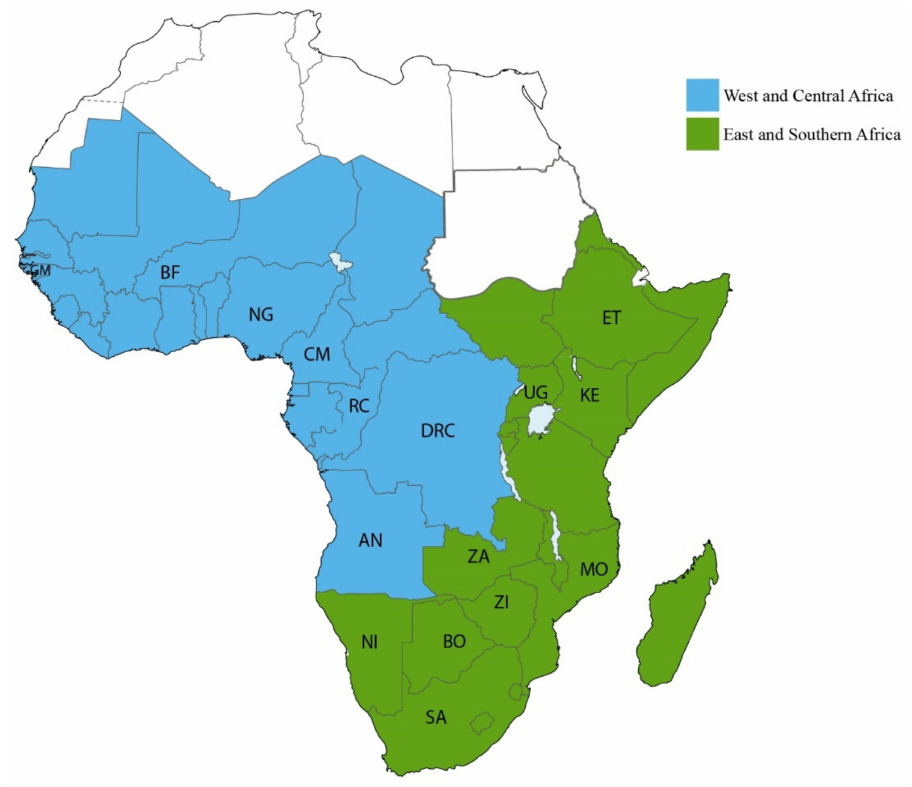
Figure 2. Subregions of Sub-Saharan Africa. A map showing different subregions of Sub-Saharan Africa as defined by UNAIDS. Countries belonging to Central and West Africa ( N = 25) are coloured blue whereas countries belonging to Eastern and Southern Africa ( N = 24) are coloured green. Where published information on HIV-1 transmission is available, the country code is included in the map. Countries belonging to Central and West Africa include Angola (AN), Benin, Burkina Faso, Cameroon (CM), Cape Verde, Chad, Central African Republic, Republic of the Congo (RC), C ô te D’Ivoire, Democratic Republic of Congo (DRC), Equatorial Guinea, Gabon, The Gambia, Ghana, Guinea, Guinea-Bissau (GM), Liberia, Mali, Mauritania, Niger, Nigeria (NG), Saint Helena, Senegal, Sierra Leone, and Togo. Countries belonging to Eastern and Southern Africa include Burundi, Botswana (BO), Comoros, Djibouti, Ethiopia (ET), Eritrea, Kenya (KE), Lesotho, Madagascar, Malawi, Mauritius, Mozambique, R é union, Namibia (NI), Rwanda, Seychelles, Somalia, Somaliland, Tanzania, South Africa (SA), Eswatini (former Swaziland), Uganda (UG), Zambia (ZA), and Zimbabwe